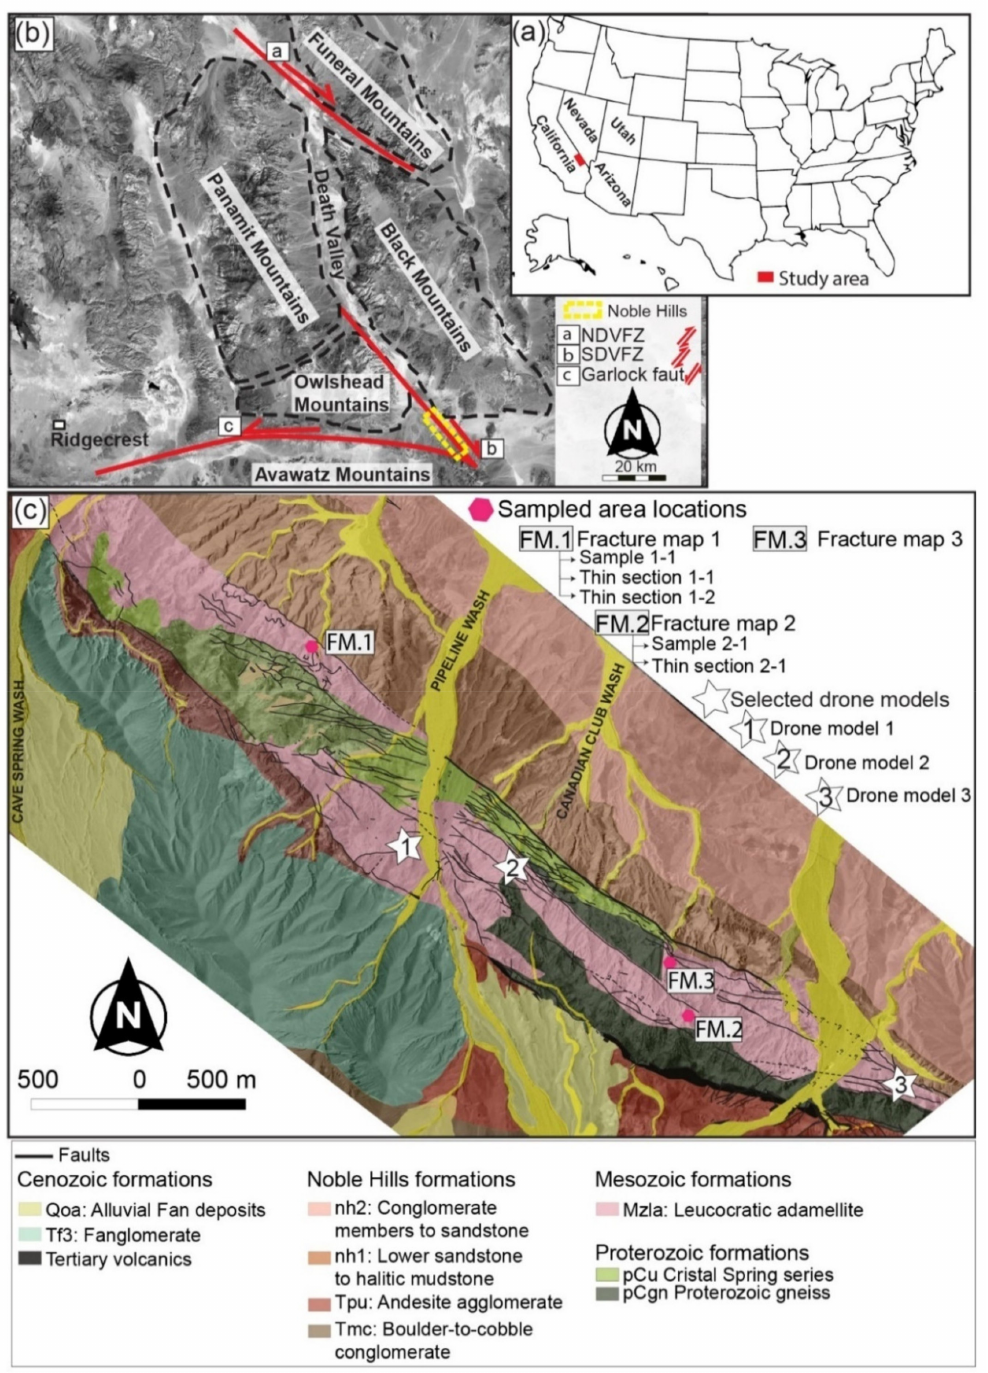
Figure 1. ( a , b ) Location and geological setting of DV, NDVFZ: Northern Death Valley Fault Zone, SDVFZ: Southern Death Valley Fault Zone; ( c ) Structural scheme of the NH range built using high-resolution digital mapping techniques modified after [37,39]. Additional digitized fractures were performed using orthophotos. The aerial picture in ( b ) was extracted from Google Earth ® . The samples location was reported in the structural scheme. FM: fracture